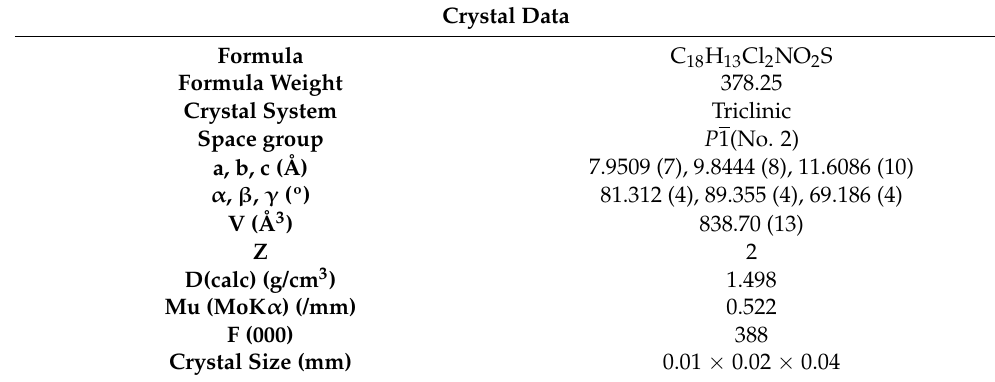
Table 1. Crystal data and refinement for compound 15 .